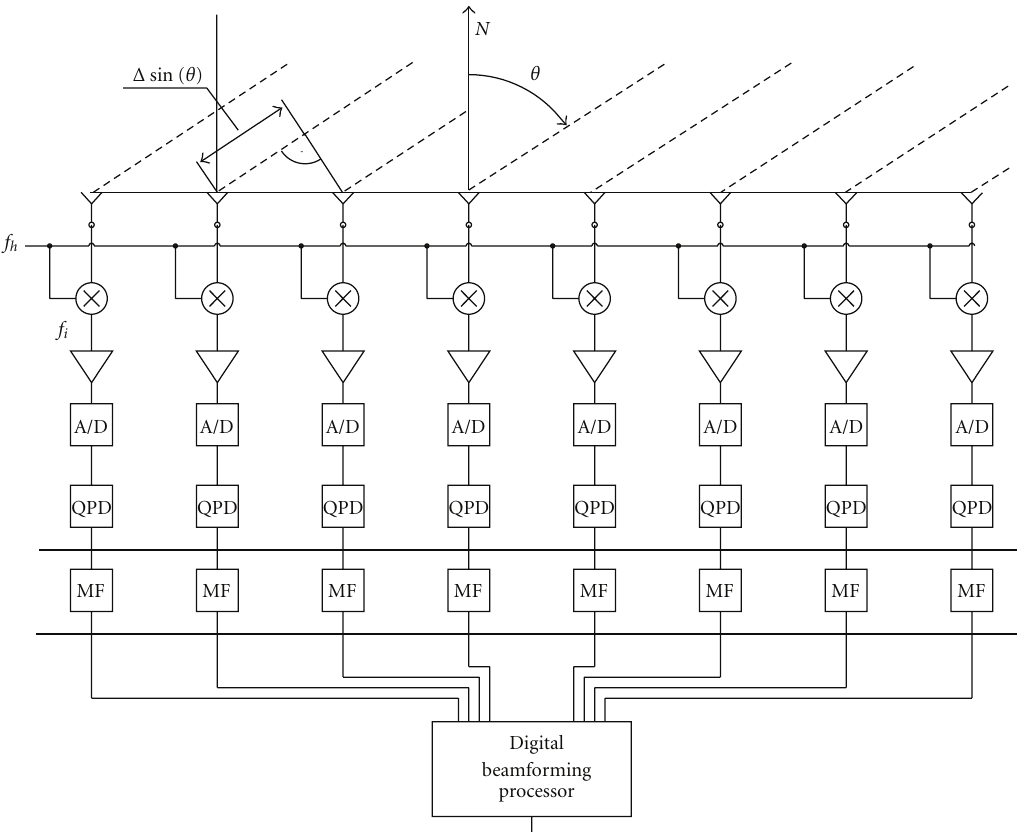
Figure 4: The functional scheme of an antenna unit including the digital beamformer. A/D: analog to digital converter, QPD: quadrature phase detector, MF: digital matching